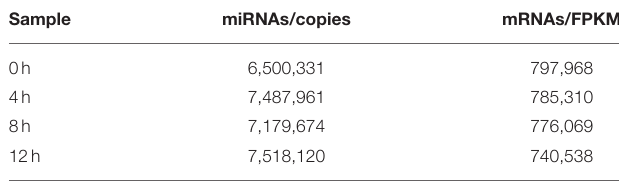
TABLE 3 | The number of types for miRNA at 0, 4, 8, and 12h, respectively. Sample